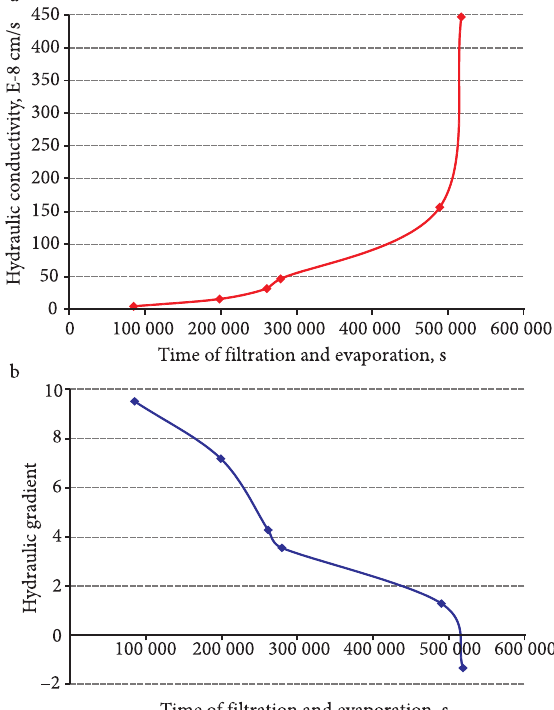
Fig. 4. Results of simultaneous filtration and evaporation experiment (the sample surface covered with the perforated plate and steel screen): a – hydraulic conductivity dependence on time; b – hydraulic gradient dependence on